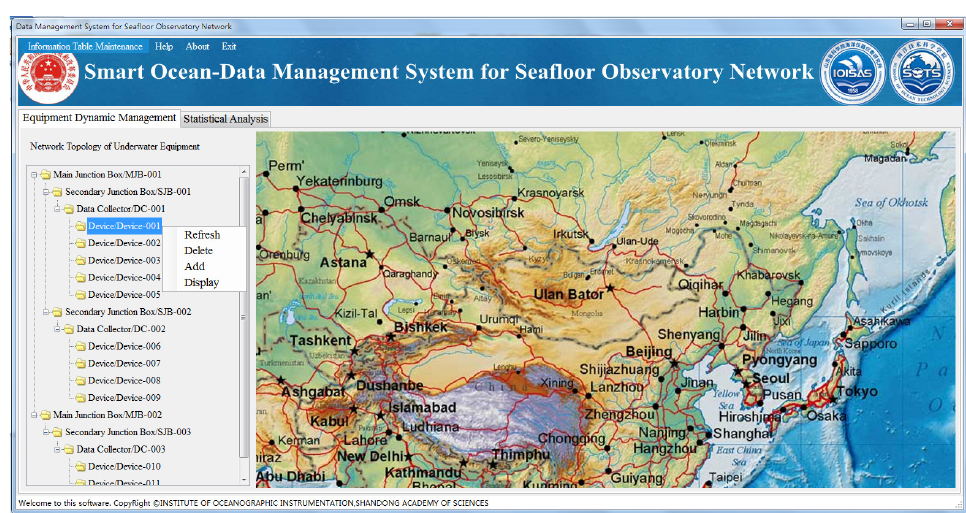
Figure 11. The interface of the device dynamic management for monitoring